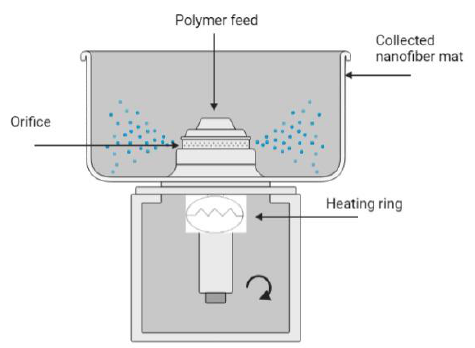
Figure 5. Melt RJS scheme (modified with permission from [72], Copyright 2012 American Chemical Society).